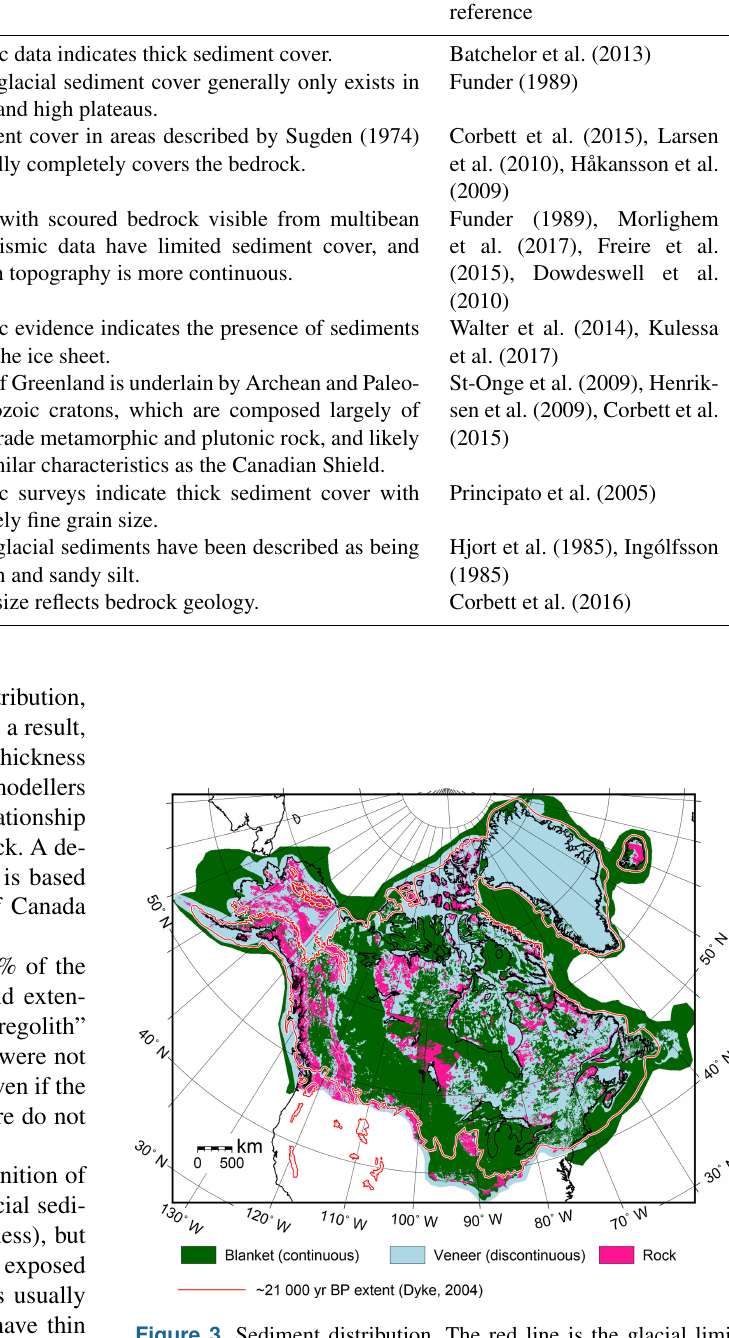
Figure 3. Sediment distribution. The red line is the glacial limit during the Last Glacial Maximum, 21000yrBP (thousands of years ago). Blanket regions are where unconsolidated sediments form a continuous surface, veneer regions have variable amounts of rock outcrops and discontinuous sediment cover, while rock areas have little or no sediment